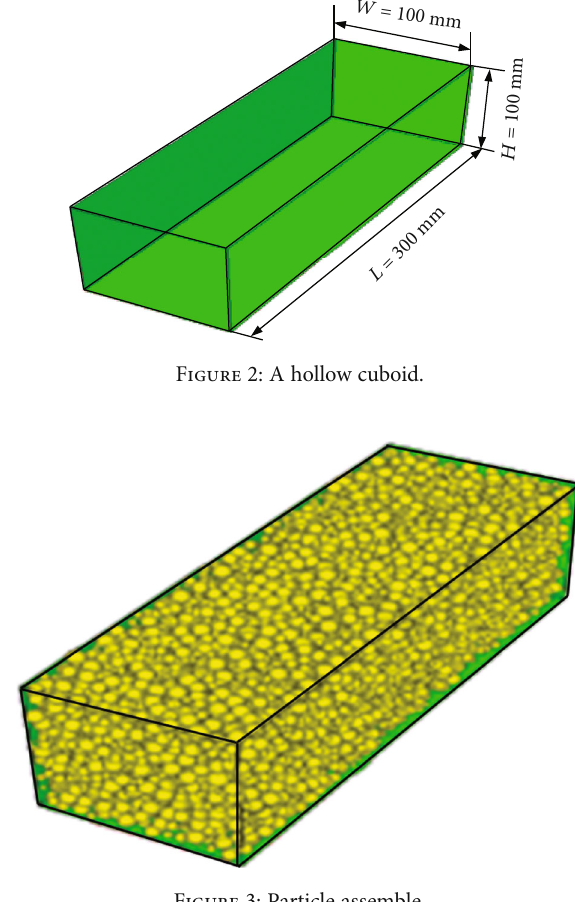
Figure 3: Particle assemble.